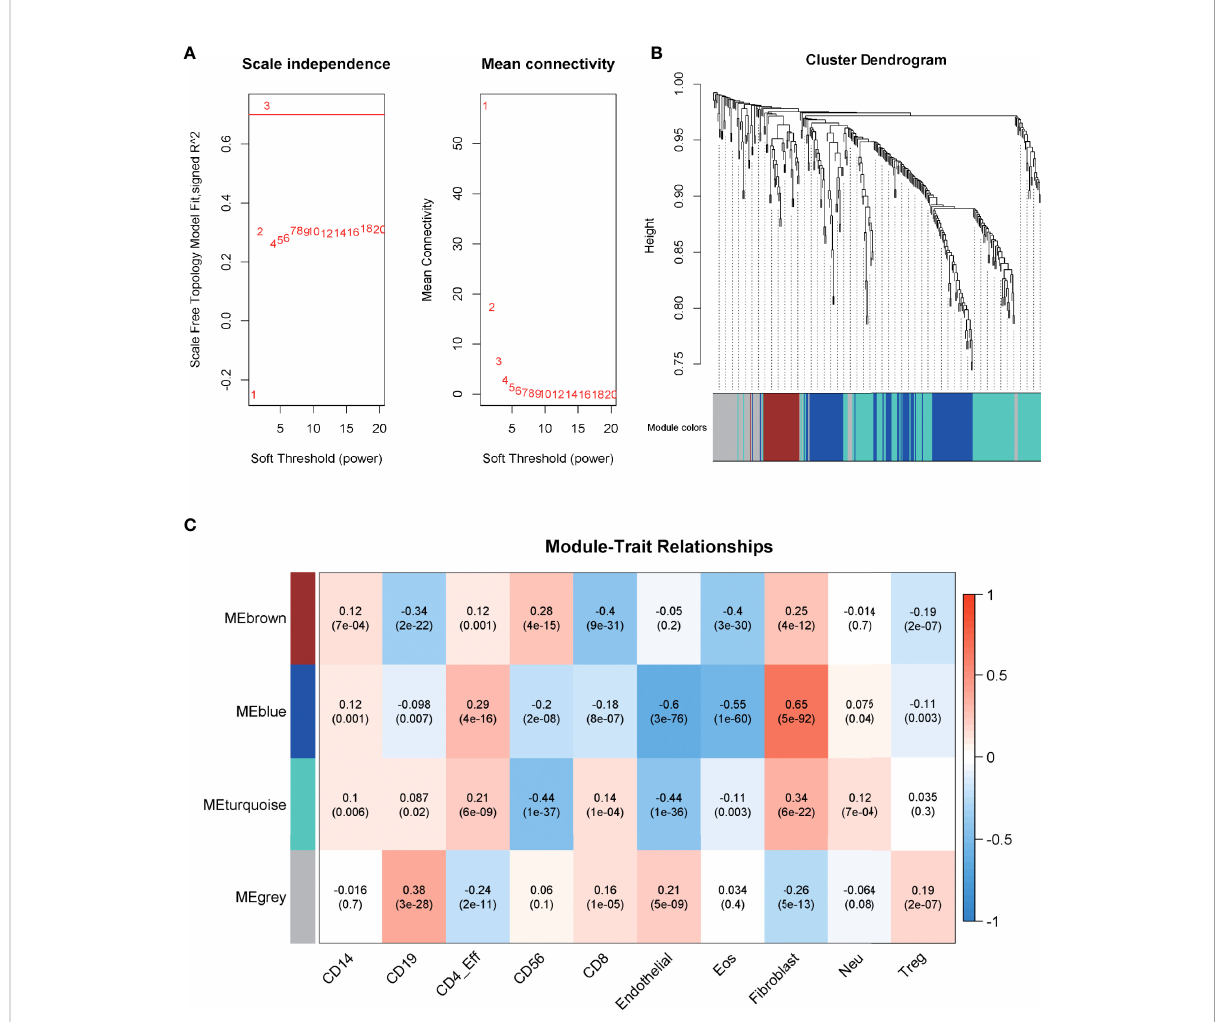
FIGURE 3 Construction of the co-expression network. (A) The parameters for the scale-free topology criterion. (B) Cluster the genes into different modules with different reprehensive colors among different modules. (C) The degree of immune cell in fi ltration of samples was collected, and module – trait relationships were calculated according to the